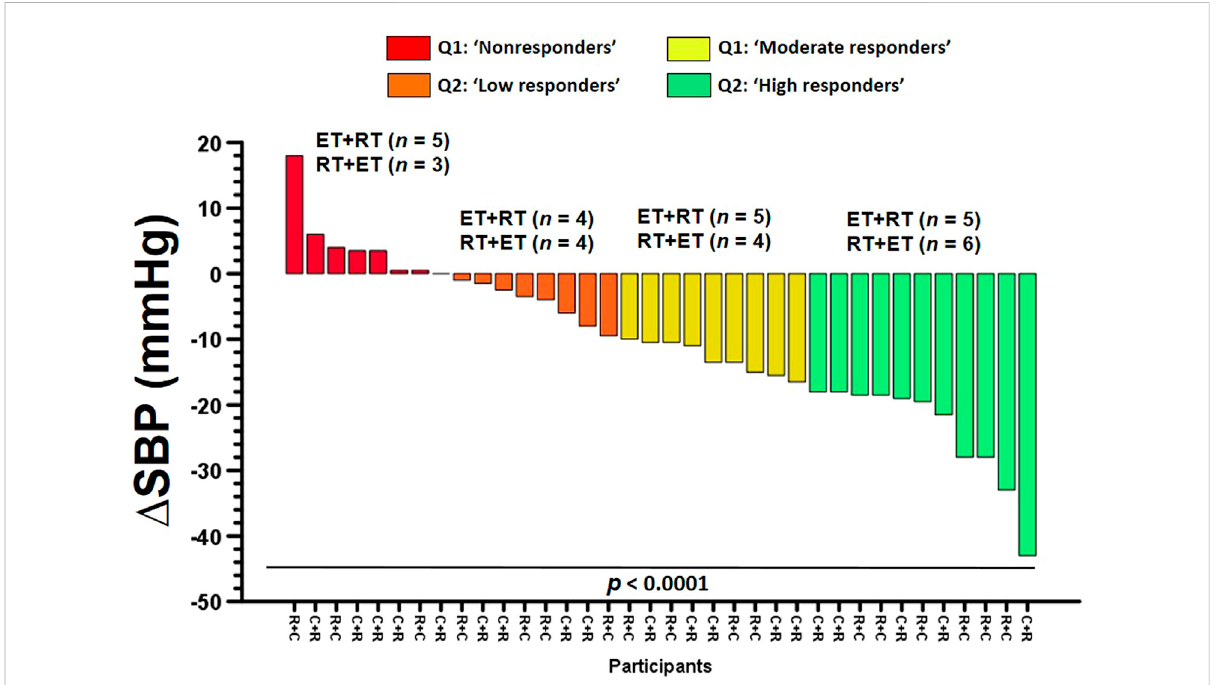
FIGURE 6 Interindividual response for systolic blood pressure participants of 4 weeks (eight exercise sessions) of two order groups of concurrent training in morbid obesity patients. Groups are described as (ET + RT) endurance training plus resistance training group and (RT + ET) resistance training plus endurance training group. Categories are described as (Q1: NRs) quartile 1nonresponders, (Q2: LRs) quartile 2low responders, (Q3: MRs) quartile 3moderate responders, and (Q4: HRs) quartile 4high responders to exercise training for decreasing blood